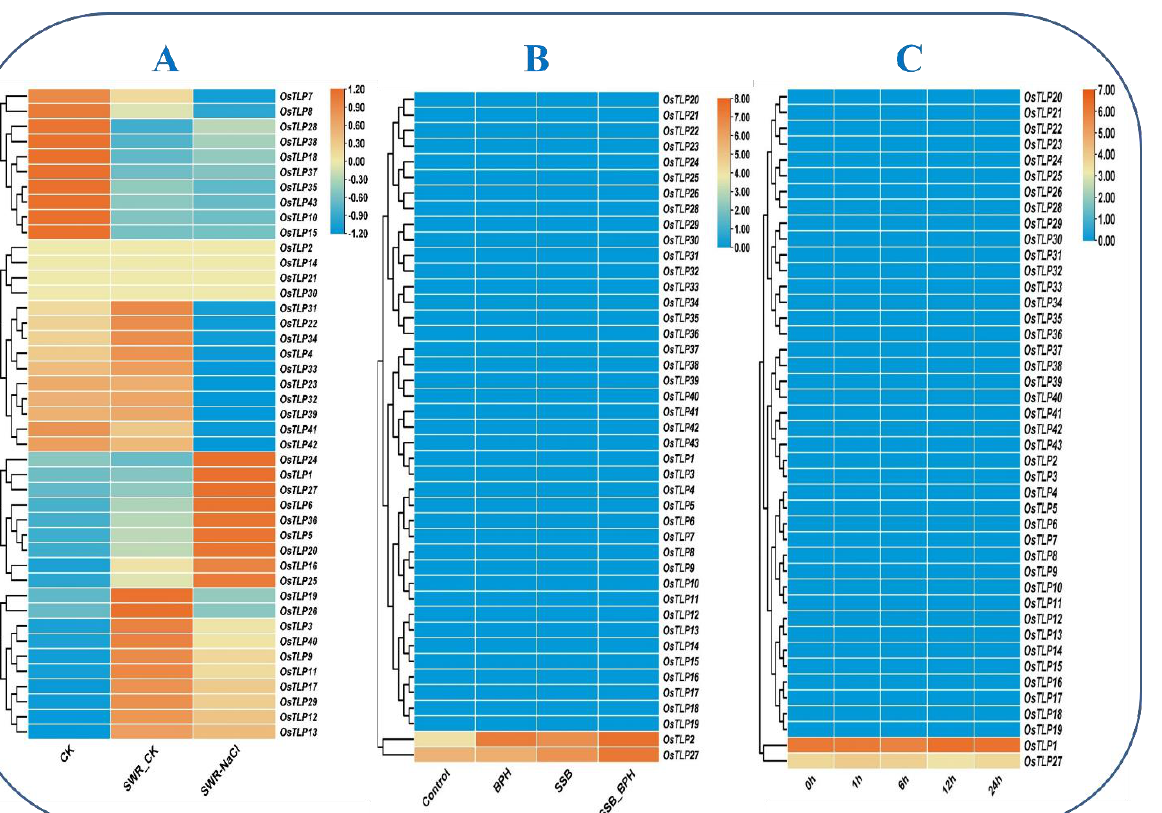
Figure 6. Heatmap of OsTLP genes representation in developmental stages, including leaf blade, leaf sheath, root, stem, inflorescence, pistil, lemma, plea, ovary, embryo, and endosperm. The log2 transformation method normalized and converted the RPKM values displayed.